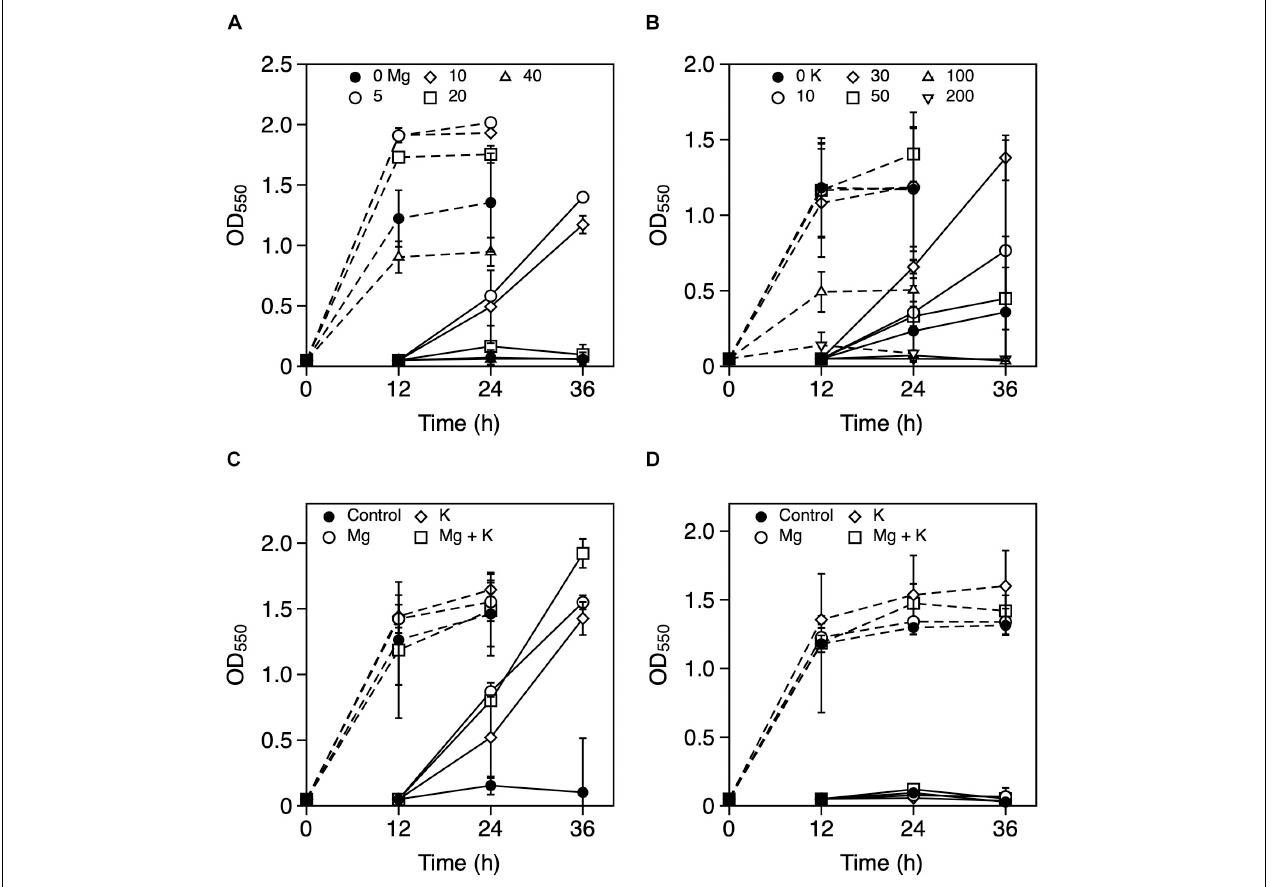
FIGURE 2 | Effects of Mg 2 + and K + on the growth of Zymomonas mobilis TISTR 548 at critical high temperatures. Cells were cultivated in YPD medium with several concentrations of MgCl 2 ( A: closed circle, 0 mM; open circle, 5 mM; open diamond, 10 mM; open square, 20 mM; and open triangle, 40 mM) and KCl ( B: closed circle, control, 0 mM; open circle, 10 mM; open diamond, 20 mM; open square, 50 mM; open triangle up, 100 mM; and open triangle down, 200 mM) at 39 ◦ C under a static condition. At 39 ◦ C (C) and 39.5 ◦ C (D) , 5 mM MgCl 2 (open circle), 30 mM KCl (open diamond), and a combination of these metals (open square), were added, and two-step cultivation was performed. Values and error bars represent means and standard deviations, respectively, for triplicate